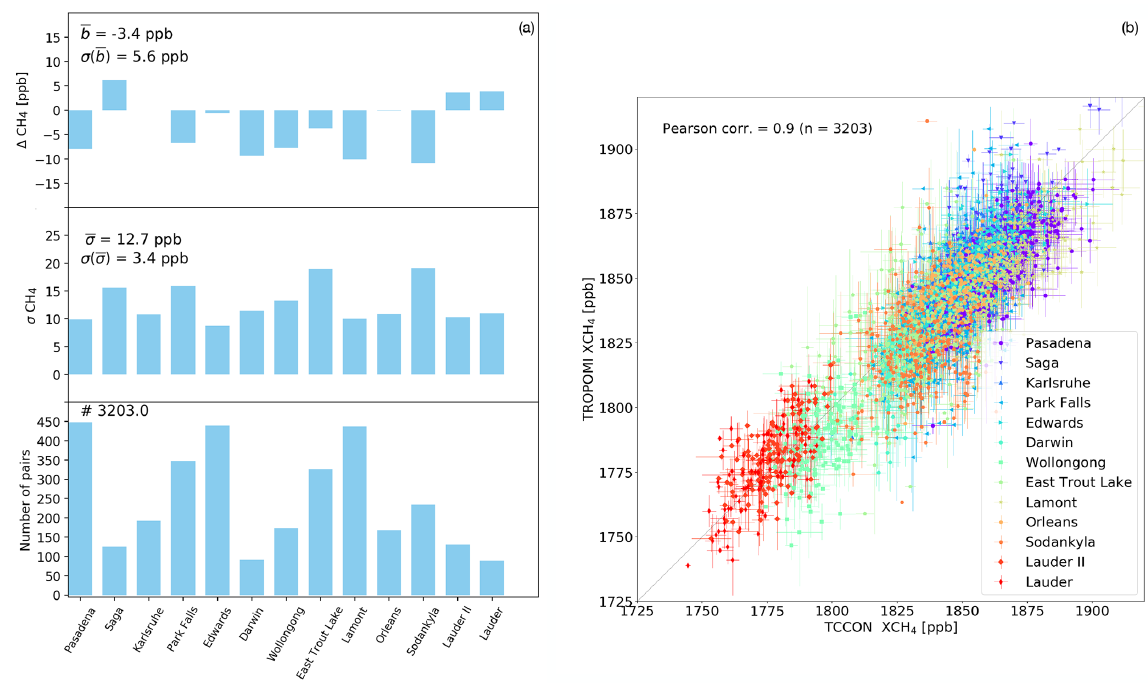
Figure 8. (a) Mean differences between TROPOMI and TCCON XCH 4 ( (cid:49) XCH 4 ), the standard deviation of the differences ( σ XCH number of collocations for each of the stations selected for the validation. (b) Correlation of daily average XCH 4 measured by TROPOMI and TCCON for all the stations.